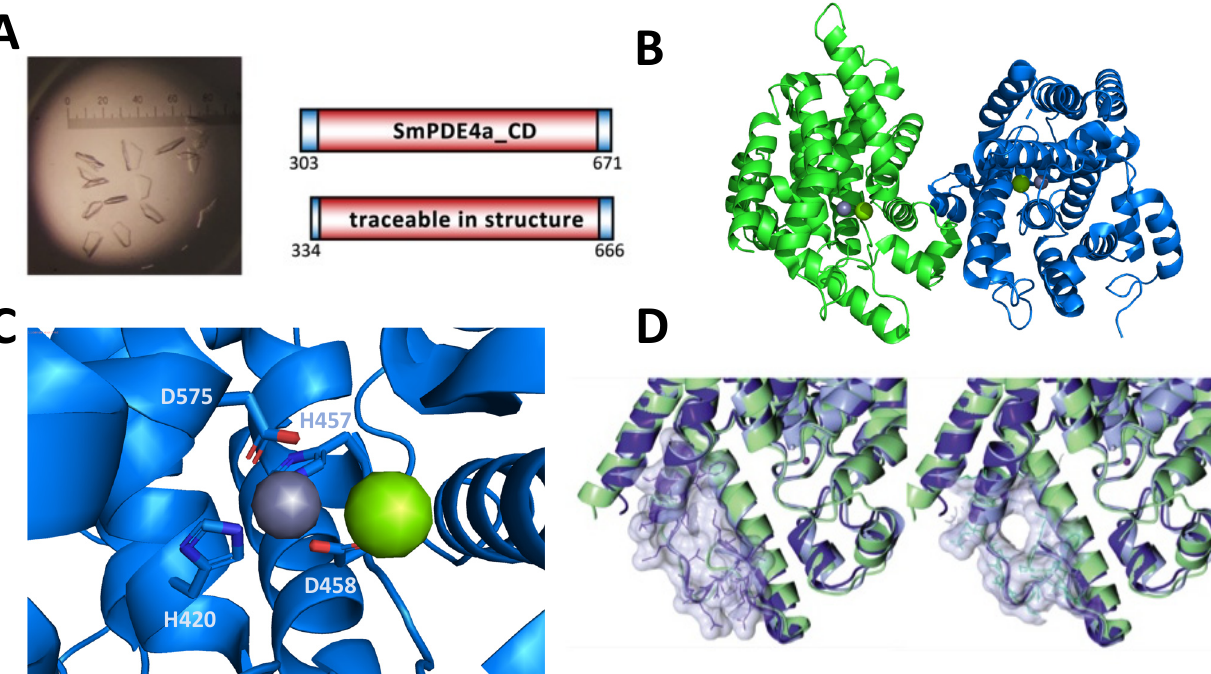
Figure 2. Crystal structure of SmPDE4A and comparison with other PDEs. ( A ) Crystallization of SmPDE4A_CD in 0.4 M ammonium sulfate 12–14% ( v/v ) PEG 3350 and structural features of the catalytic domain of SmPDE4A. ( B ) The protein crystallizes in a dimer form and contains two metal ions (the grey ball represents Mg 2+ , and the purple ball represents Zn 2+ ). ( C ) These metal ions are coordinated by a number of histidine and aspartic acid residues in the active site. ( D ) the SmPDE4A structure (dark purple) is superimposed on the catalytic domain structures of LmjPDEB1 (PDB code: 2R8Q, green) and hPDE4D (PDB code: 3SL3, light blue). The surface is shown of residues within the P-pocket region in SmPDE4A (left) and LmjPDEB1 (right).